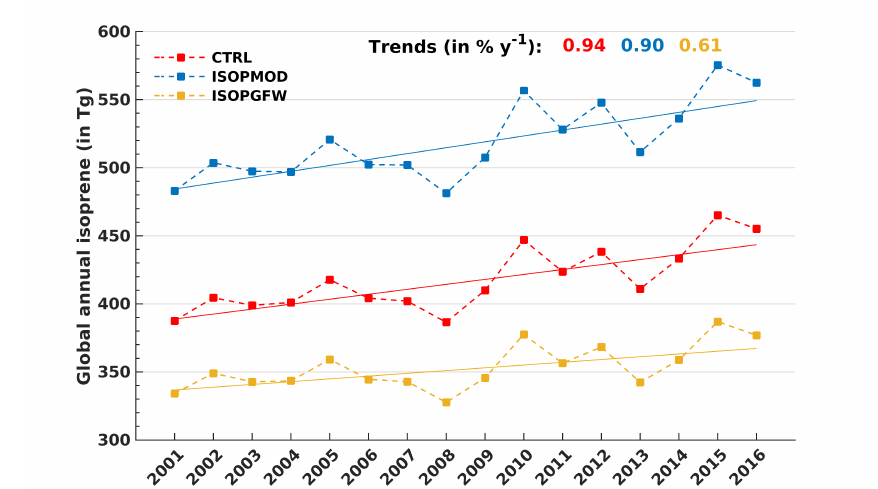
Figure 6. Time series of global annual isoprene emissions from the CTRL, ISOPMOD, and ISOPGFW